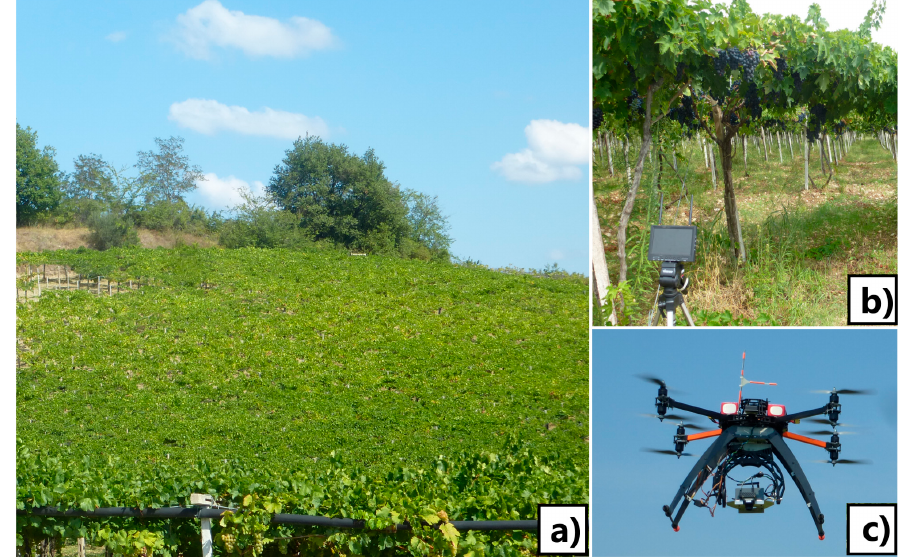
Figure 1. Montepulciano vineyard (V1) trained with a tendone trellis system ( a , b ) monitored with the unmanned aerial vehicle (UAV) platform equipped with a multispectral camera ( c ).